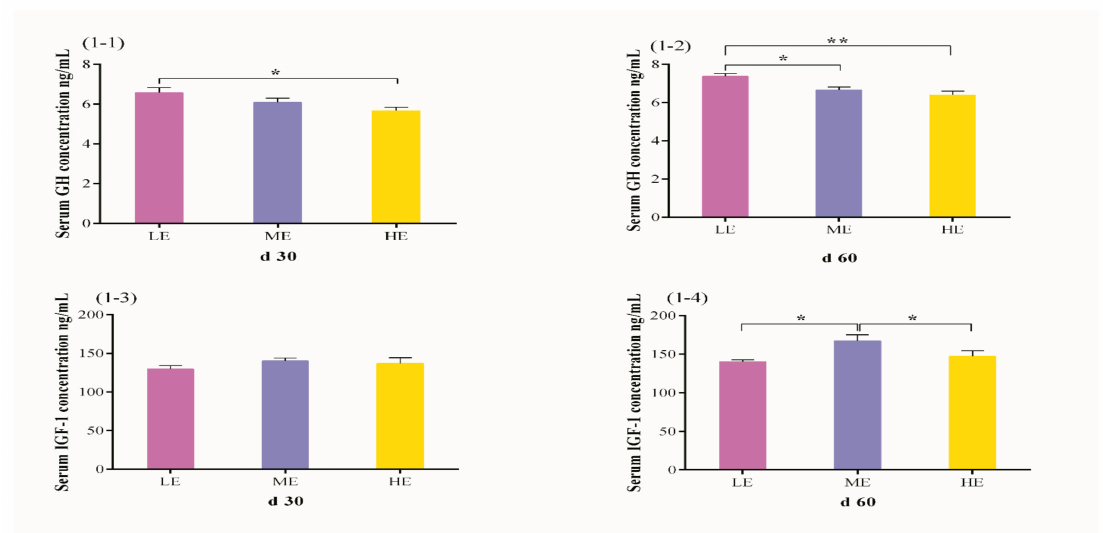
Figure 1. Effects of different dietary energy levels on serum concentration of GH ( 1-1 , 1-2 ) and IGF-1 ( 1-3 , 1-4 ) in yak. The sampling day for each group are day 30 and day 60 during the whole experimental period. GH, growth hormone; IGF-1, insulin-like growth factor 1. Values are presented as mean ± SEM (standard error of mean). Within the same day of GH and IGF-1, * and ** indicate p < 0.05 and p < 0.01,